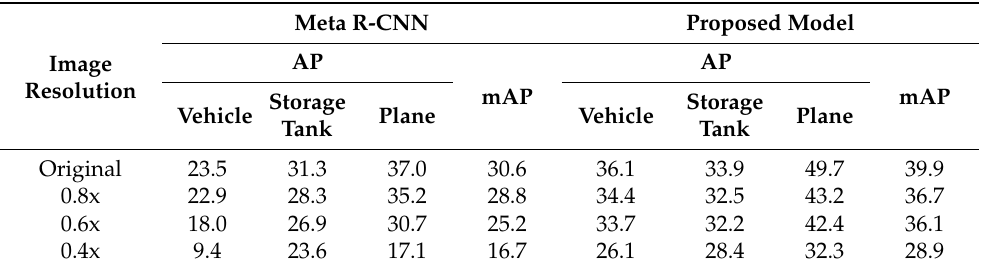
Figure 3. Images of different resolutions and the change trend of AP of different objects and mAP with the increase of resolution. Images ( a – c ) are a series of down-sampled images. Image ( d ) is the original picture. Table 4. Impact of resolution on performance of Meta R-CNN and our model when detecting novel classes.